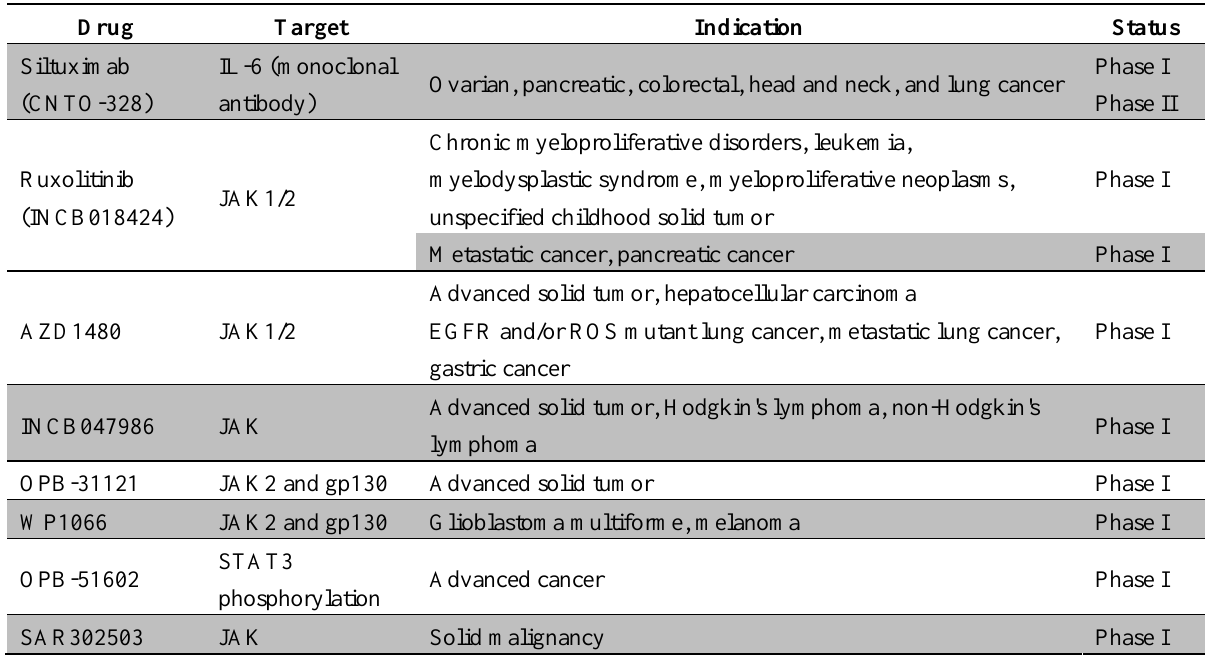
Table 1. STAT3 inhibitors tested in clinical trials for solid